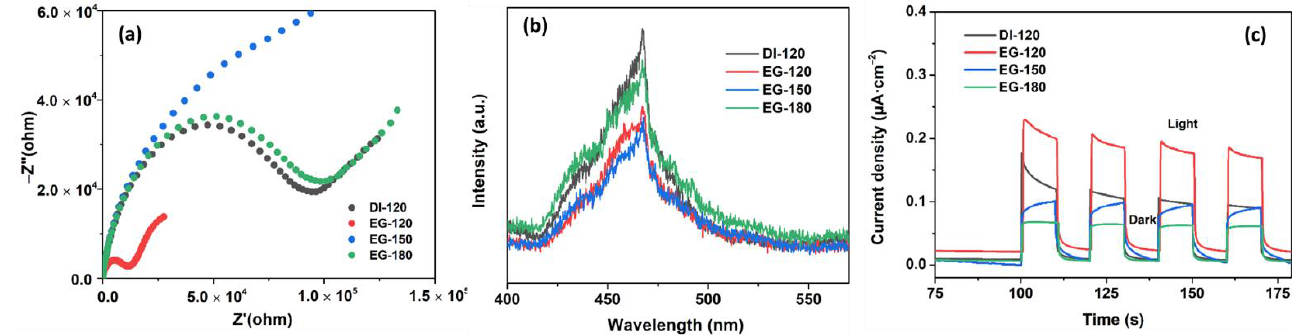
Figure 5. ( a ) electrochemical impedance spectroscopy, ( b ) photoluminescence spectra, and ( c ) tran- sient photocurrent response of different ZnIn 2 S 4 photocatalysts irradiated with visible light.